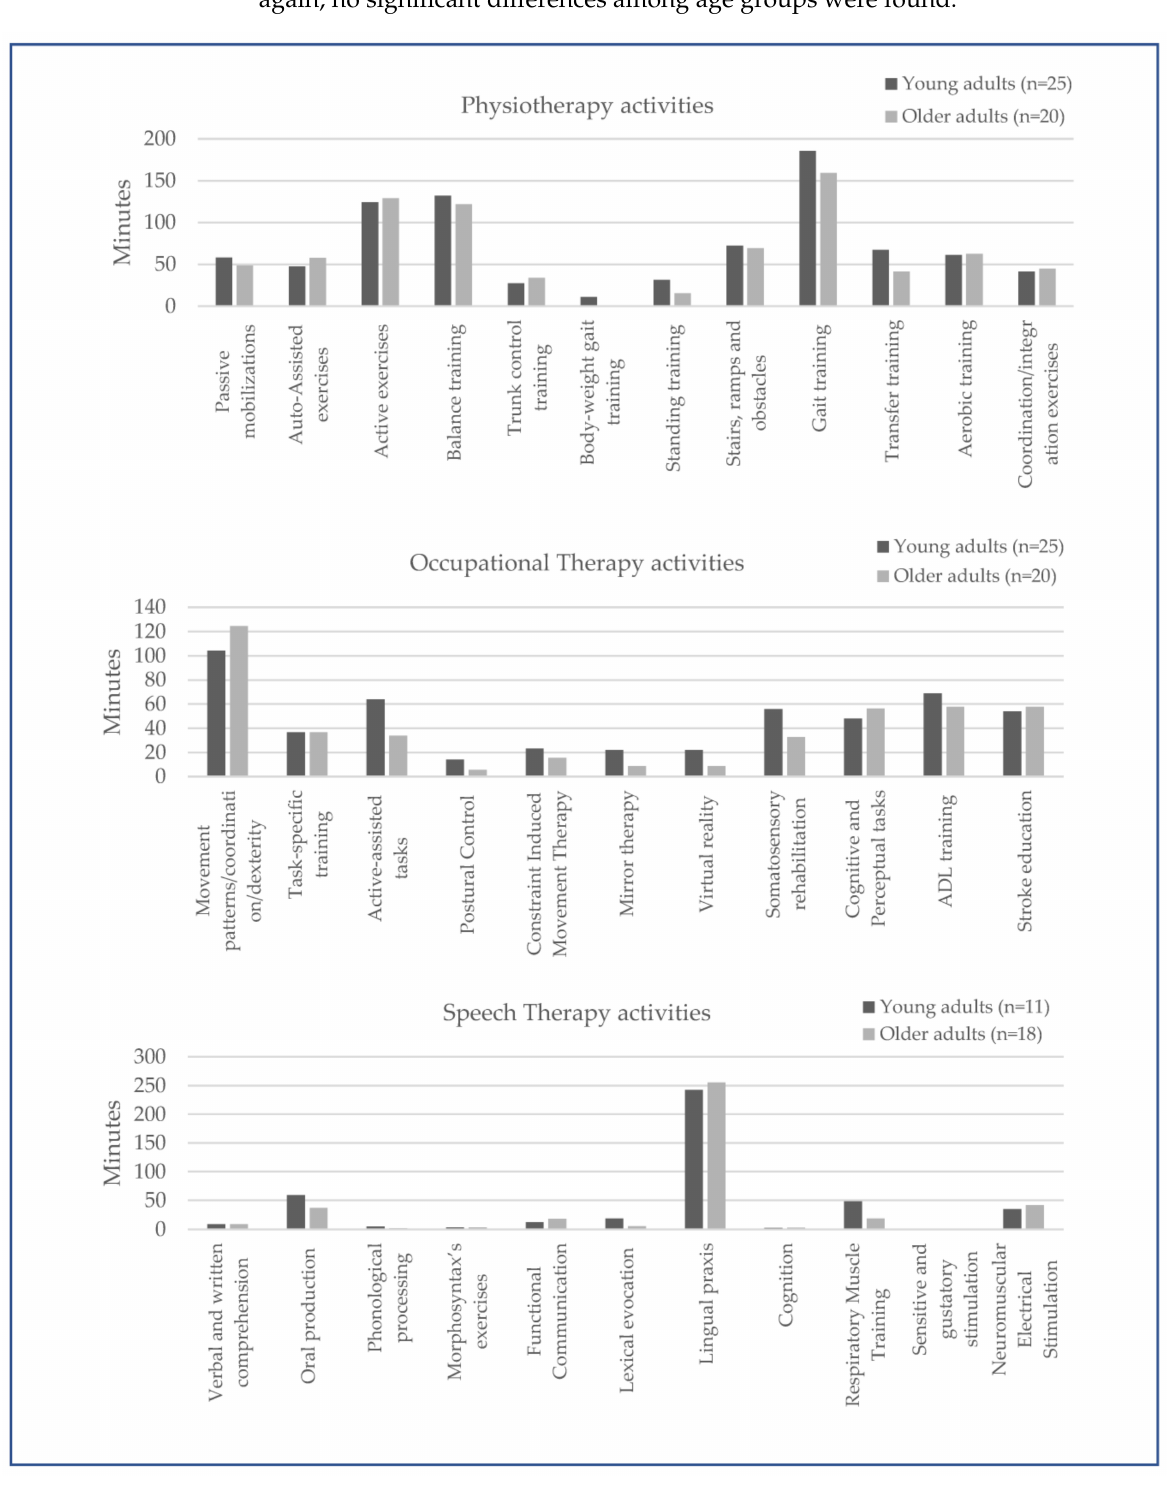
Figure 1. Mean daily time allocated to physical, occupational, and speech therapies in patients according to